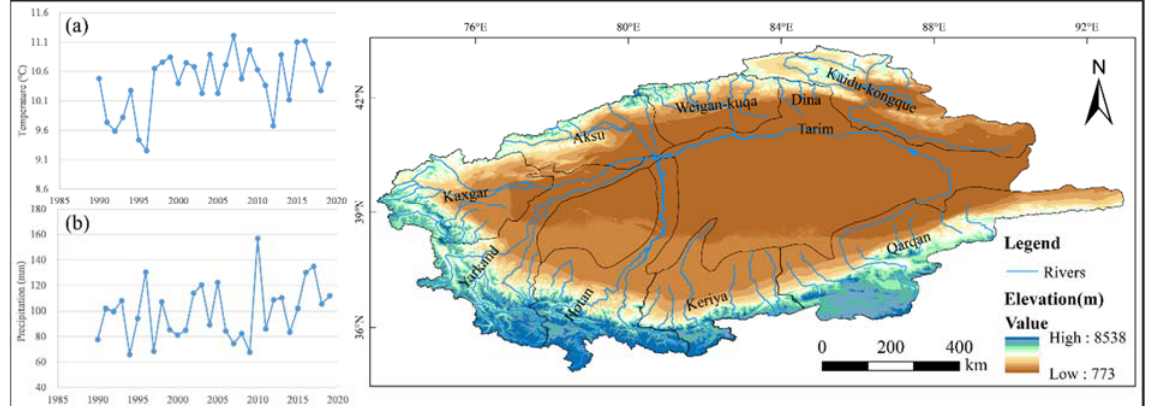
Figure 1. Sketch map of the Tarim River Basin, China. The water and elevation information comes from the Resources and Environment Data Center of the Chinese Academy of Science (http://www.resdc.cn (accessed on 26 May 2022)). ( a ) Average annual temperature of the Tarim River basin. ( b ) Average annual precipitation in the Tarim River Basin.